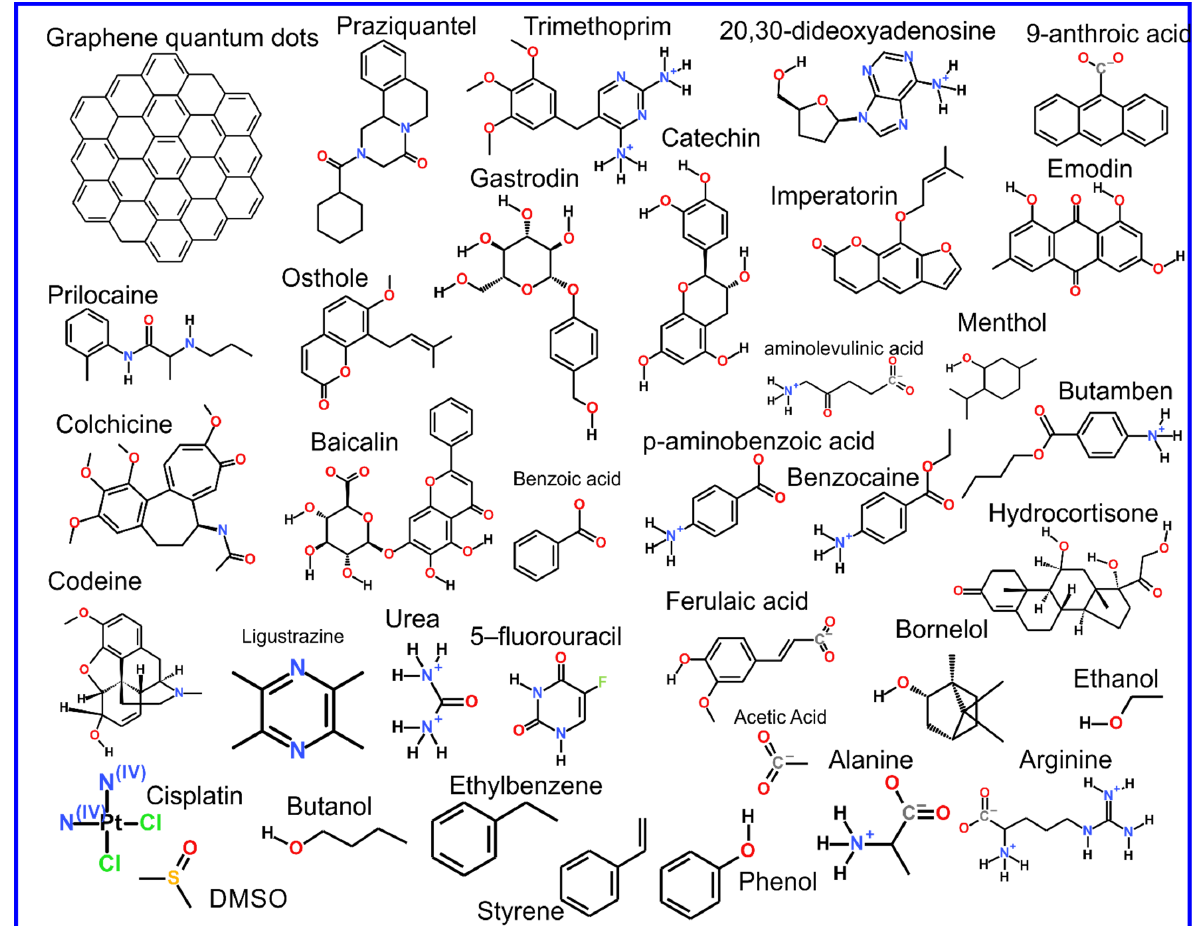
Figure 9. Chemical structure of the chemical compounds introduced in Section